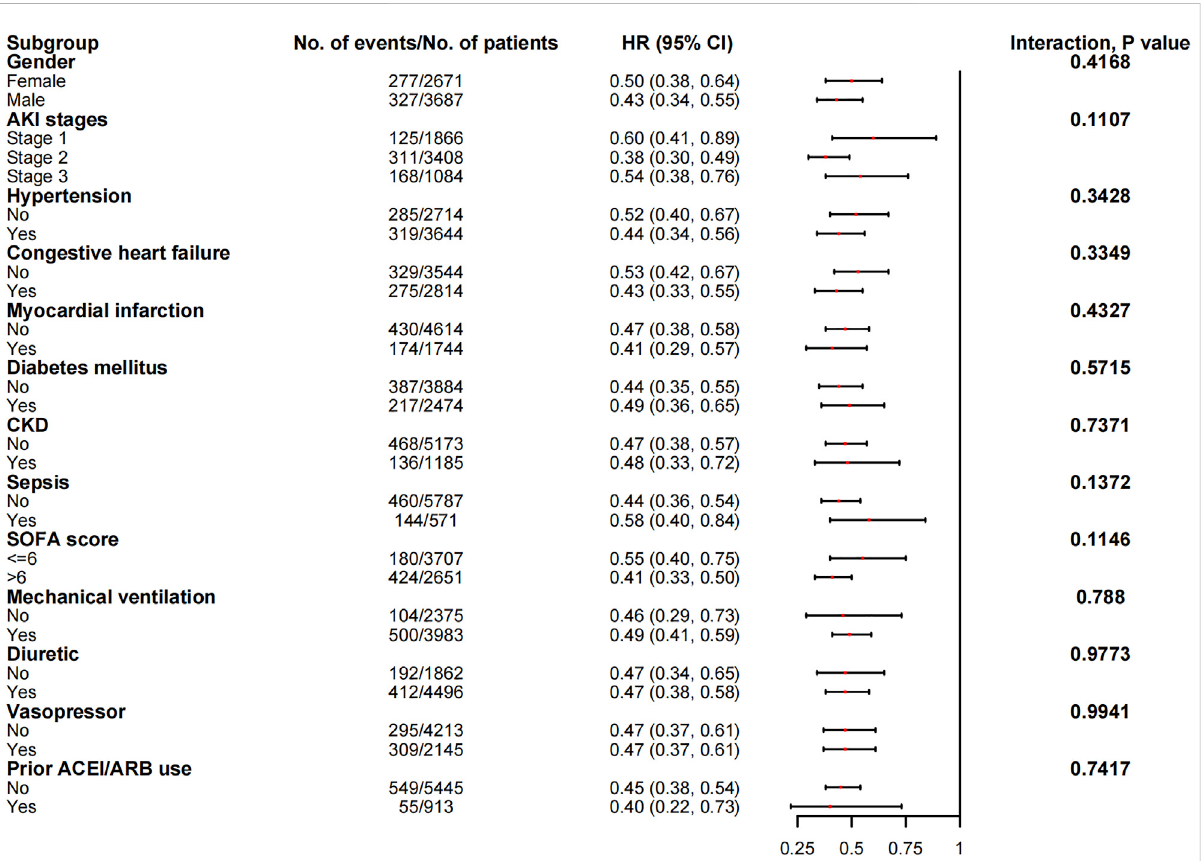
FIGURE 5 The association between ACEI/ARB use and in-hospital mortality in the subgroups. Abbreviations: AKI, acute kidney injury; ACEI, angiotensin- converting enzyme inhibitor; ARB, angiotensin receptor blocker; CI, con fi dence interval; CKD, chronic kidney disease; HR, hazard ratio; SOFA, sequential organ failure assessment